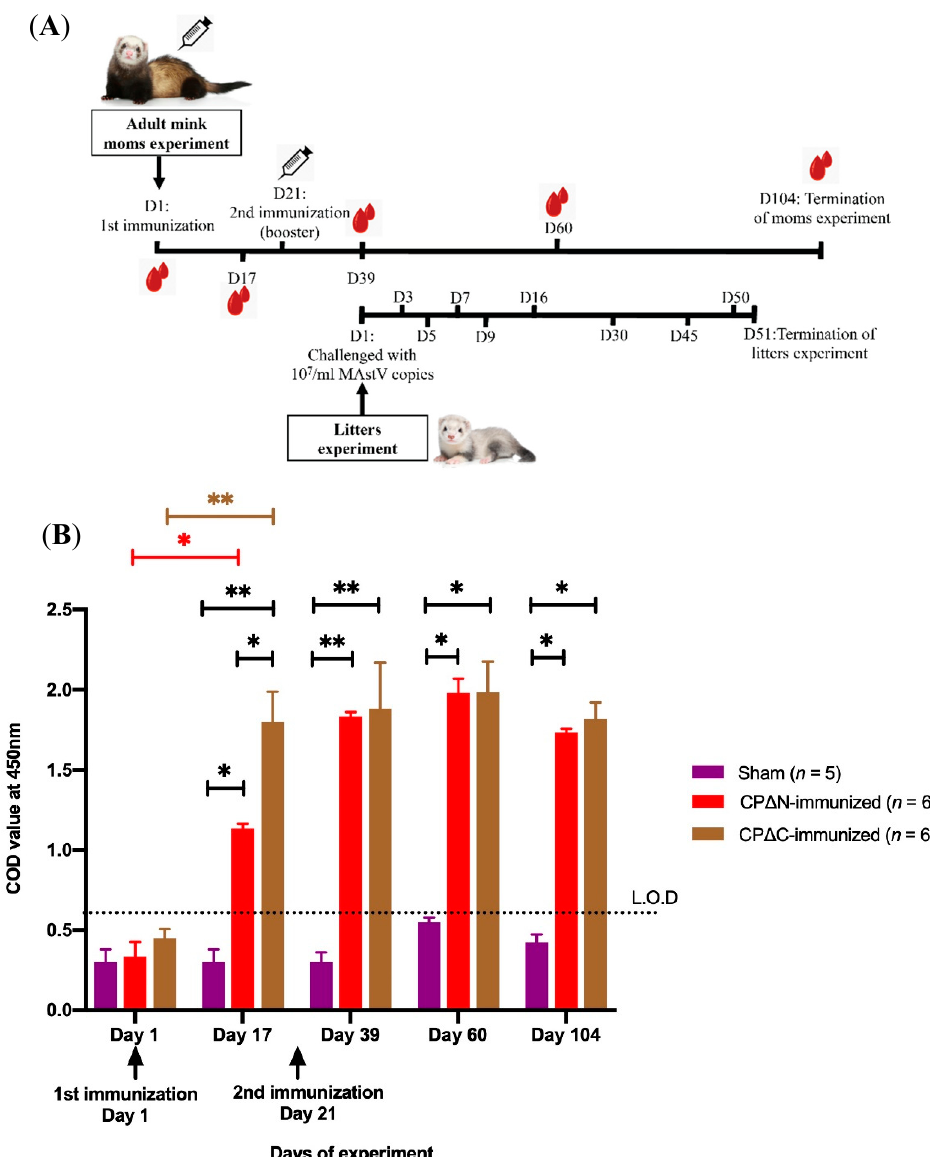
Figure 5. Schema of mink immunization and ELISA of the humoral immune response to mink astrovirus capsid protein (MAstV CP) vaccine candidates in adult mink moms. ( A ) The MAstV vaccine candidates (100 µ g / animal) combined with an equal amount of Freund’s adjuvant were injected into female adult minks ( n = 6 per group) twice with three weeks interval. The adult moms injected with pDual-GC-vector-transfected cell lysates combined with adjuvant were also analyzed as a sham ( n = 5). On day (D) 1 after birth, the litters ( n = 89) of these immunized and sham adult mink moms ( n = 17) were then challenged orally with 10 7 / mL MAstV copies. As a follow-up, the fecal samples of their newborn litters on test days 1, 3, 5, 7, 9, 16, 30, 45, 50, and 51 after birth were tested using real-time PCR for detecting astrovirus shedding status. The clinical signs of litters were also monitored and recorded by veterinarians every other day. ( B ) Serum samples of the adult moms were collected on test days 1, 17, 39, 60, and 104 and tested with an indirect ELISA for measuring maternal antibody production against MAstV (Limit of detection (L.O.D) is the corrected optical density (COD) above 0.6). CP ∆ N refers to an N-terminal truncated protein (spanning aa 161–775 of CP) of MAstV; CP ∆ C refers to a C-terminal truncated protein (spanning aa 1–621 of CP) of MAstV; Sham refers to the control group injected with pDual-GC-vector-transfected cell lysate. Asterisks indicate significant di ff erences at the given protein concentration between various immunized and sham adult mink moms tested by a two-way ANOVA with replication test (* p < 0.01, ** p < 0.001). Error bars represent